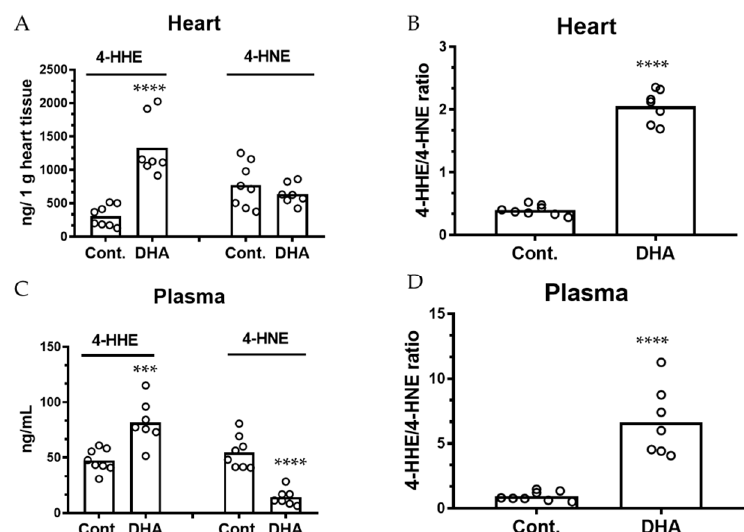
Figure 3. Maternal DHA intervention alters the levels of 4-HHE and 4-HNE and 4-HHE/4-HNE ratios in offspring heart and plasma. ( A , C ): Levels of 4-HHE and 4-HNE in heart and plasma of pups nursed by control and 1% DHA mothers, respectively. ( B , D ): Ratios of 4-HHE/4-HNE in hearts and plasma, respectively. Levels of 4-HHE and 4-HNE were measured using LC-MS/MS and normalized to tissue weight. Each value represents the mean ± SEM of eight and seven pups from control and 1% DHA diet groups, respectively. Analysis using two-tail unpaired t-test indicated significance between DHA group and controls. *** p < 0.001; **** p < 0.0001.